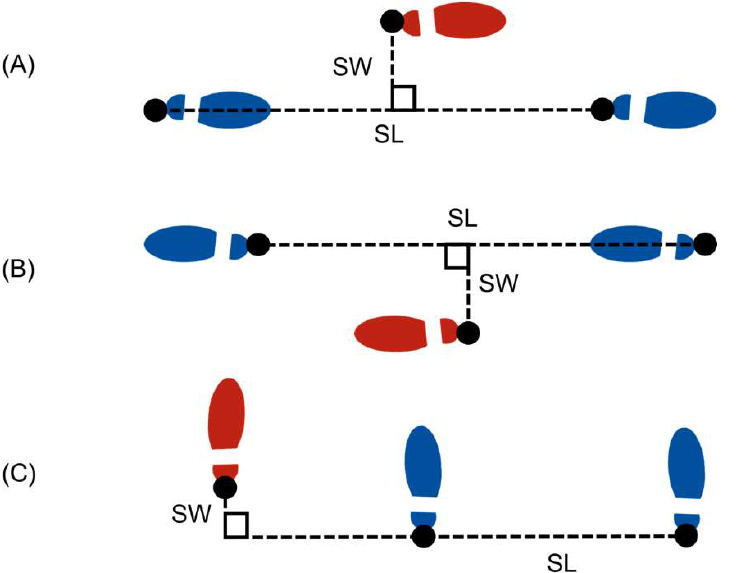
Figure 3. Stride length (SL) and step width (SW) definitions for forward walking ( A ), backward walking ( B ), and lateral walking ( C ). Shown in each subfigure are two consecutive right footfall locations (blue) with the intermediate left footfall location (red) for a subject traveling to the right. SL is the total horizontal displacement between consecutive footfalls of the same foot and SW is the orthogonal distance between the stride length vector and the intermediate footfall location of the opposite foot.